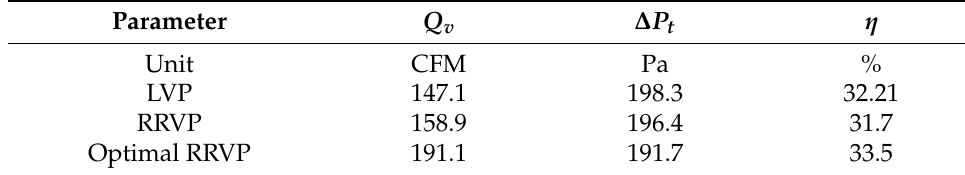
Table 6. Comparison of the